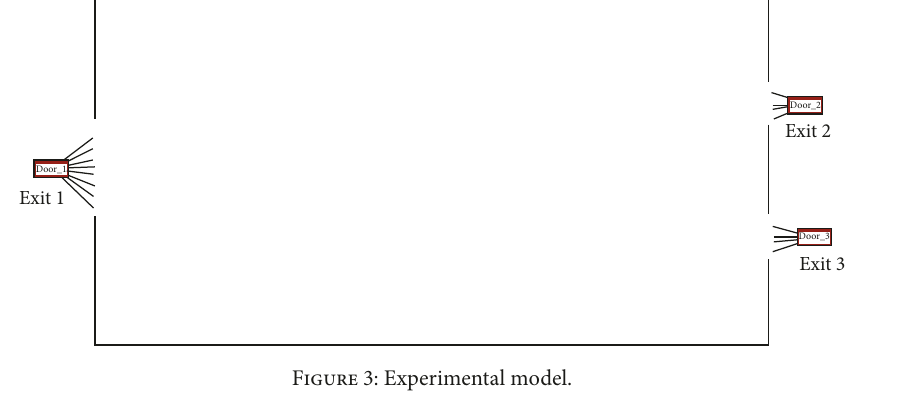
Figure 3: Experimental model. Table 2: Evacuation speed 𝑉 .